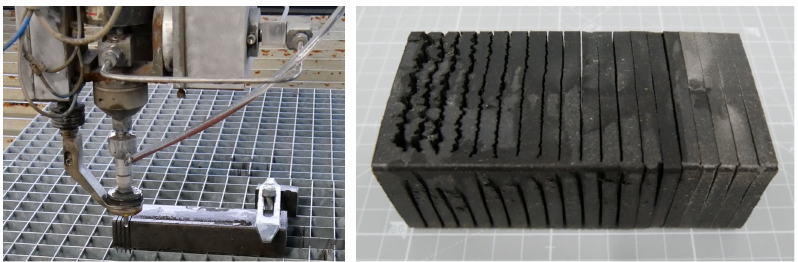
Figure 3. Clamping the workpiece on the table of the AWJ machine, divided profile—a semi-finished product.